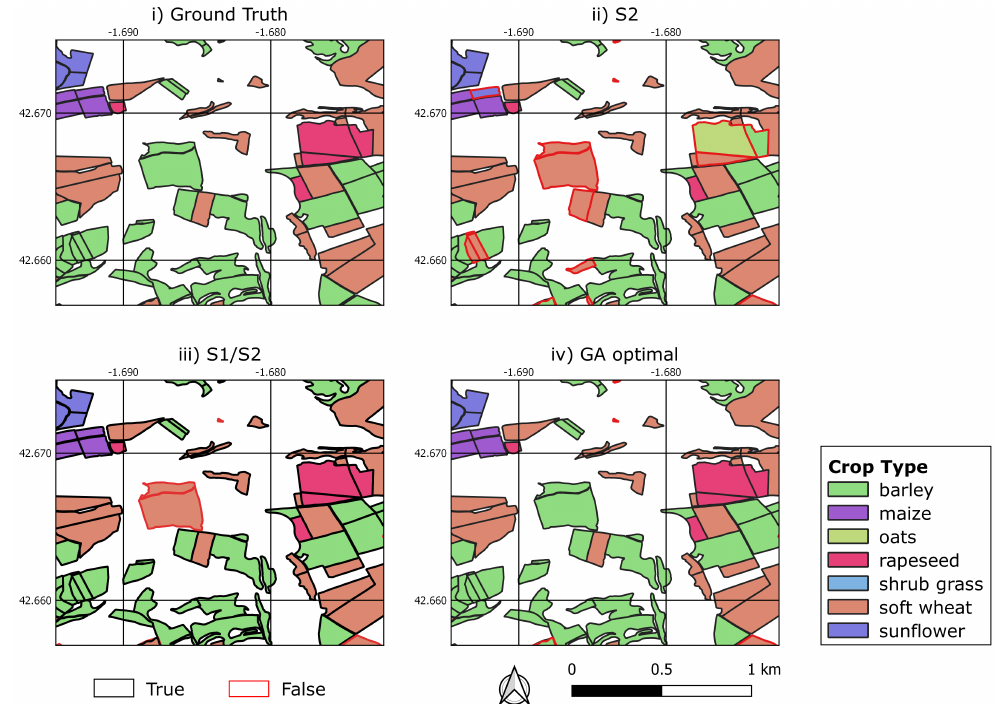
Figure 8. Crop type maps attained by the three different SVM models. ( i ) ground truth, ( ii ) predic- tions from the S2 model, ( iii ) predictions from the S1/S2 mode,l and ( iv ) predictions from the GA optimal